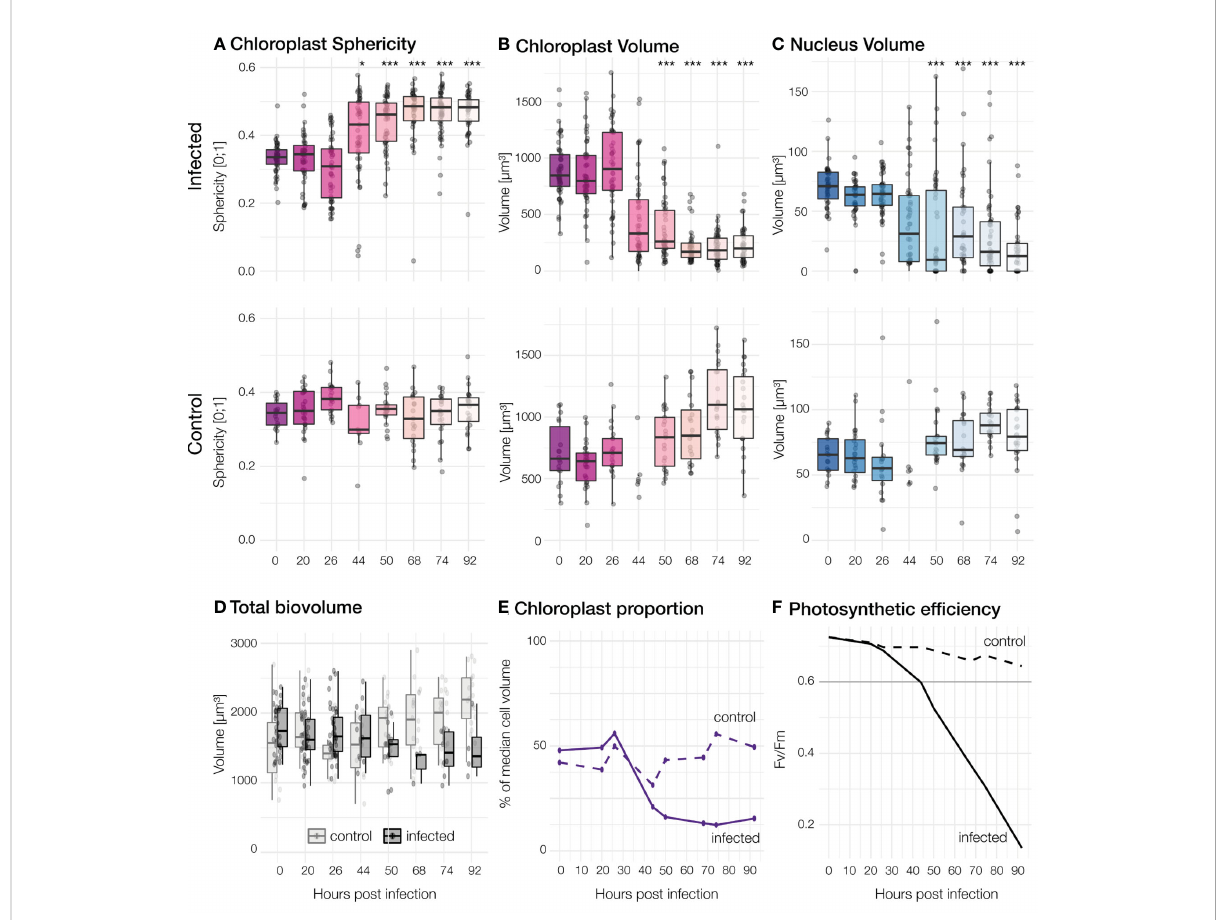
FIGURE 3 Morphological and physiological changes for different timepoints. Each dot represents one cell. Top row: Infected cells, Second row : Control cultures. Signi fi cant differences between infected and control population are marked by *** for p < 0.001< and * for p < 0.05. (A) Sphericity of chloroplasts (B) The summed volume of chloroplasts in each cell. (C) Volume of nuclei. A slight defocus in the control at 44h led to fewer quanti fi able 3D datasets of individual cells. (D) The total biovolume per cell, estimated from intact frustule size. (E) Relative proportion of chloroplast volumes compared to total volume per cell. (F) Maximum quantum ef fi ciency of Photosystem II (F v /F m ; values under 0.6 indicate